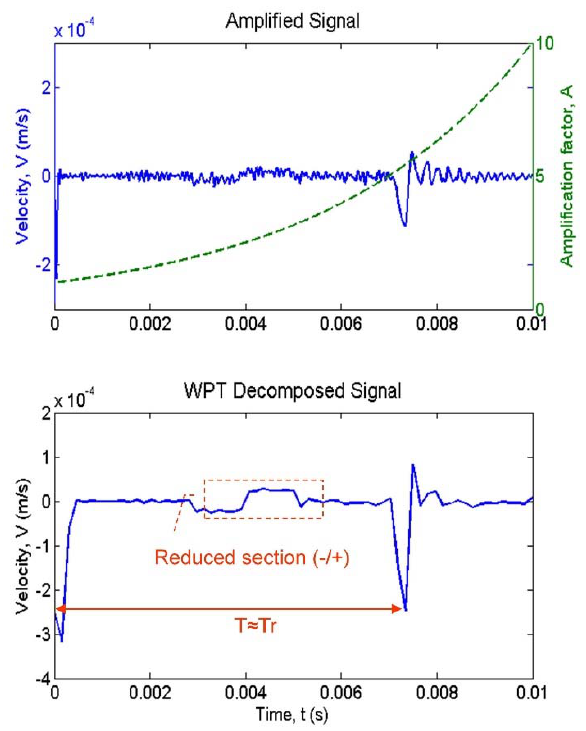
Figure 15. Amplified and WPT decomposed velocity signal for case d of dataset 5 (neck defect).